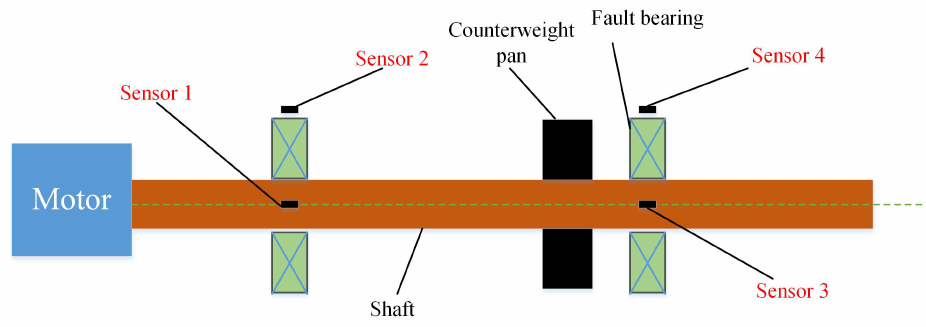
Figure 6. Schematic diagram of sensors